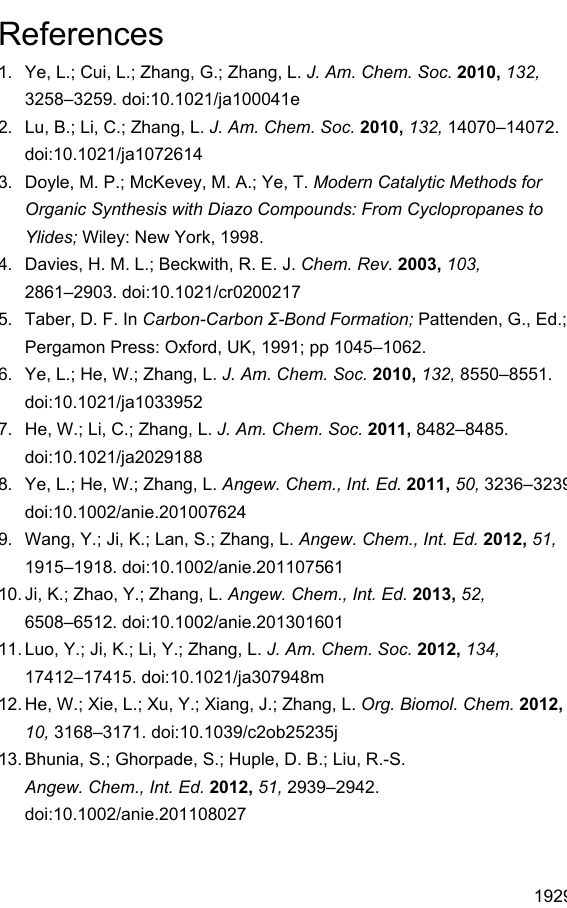
While a previous Pd catalysis [43] could also accomplish this transformation, the demonstrated scope is much limited, and the catalyst loading is 20%. With this oxidative gold catalysis, the propargyl esters, except those derived from tertiary alcohols, can be reliably converted into α -acyloxy α , β -unsaturated